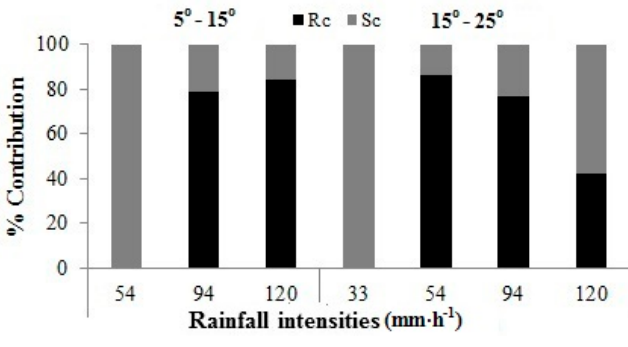
Figure 6. Rainfall (Rc) and slope (Sc) contributions for sediment losses under different rainfall intensities with increasing slope steepness from 5° to 15° and 15° to 25° in mulched Purple soil. with increasing slope steepness from 5 ◦ to 15 ◦ and 15 ◦ to 25 ◦ in mulched Purple